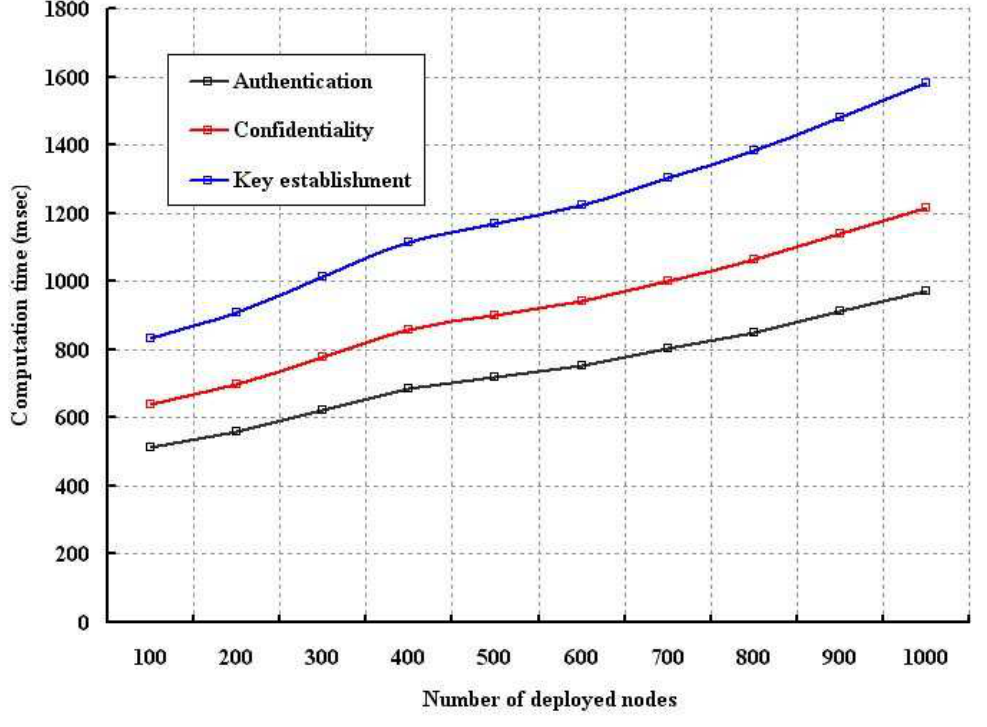
Figure 9. Evaluation of computation time with different number of nodes.